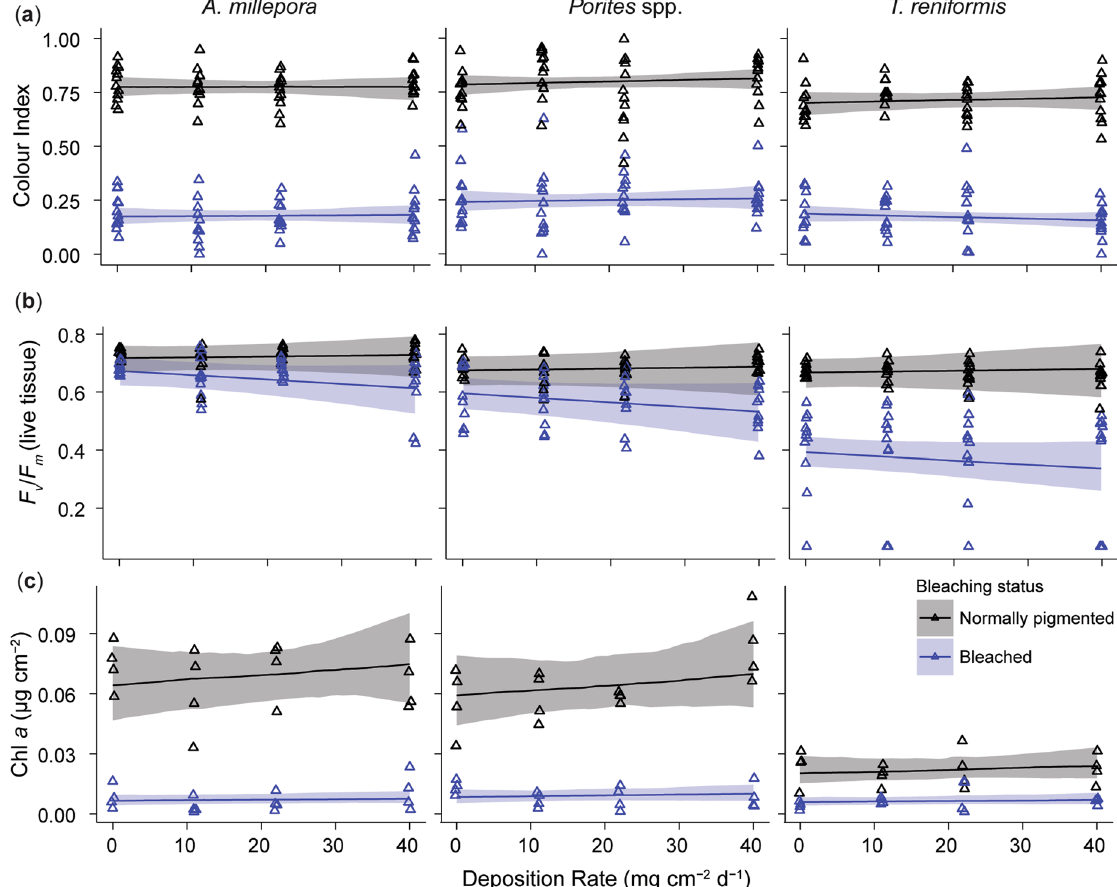
Figure 3. Physiological health parameters of bleached and normally-pigmented corals after 7 consecutive deposition events. ( a ) Colour index, ( b ) Maximum quantum yield ( F v / F m ), and ( c ) Chl a concentrations ( µ g Chl a cm − 2 ) of A . millepora , Porites spp. and T . reniformis fragments across 4 deposition rate treatments for both normally pigmented (black) and bleached (blue) fragments after 7 consecutive deposition events. Raw data (triangles) is presented with modelled relationships (lines) and 95% confidence intervals